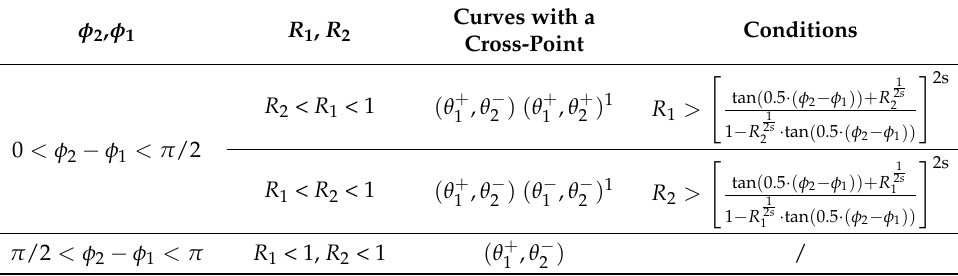
Table 1. The possible cross-points for the cosine function ( R 1 < 1, R 2 <